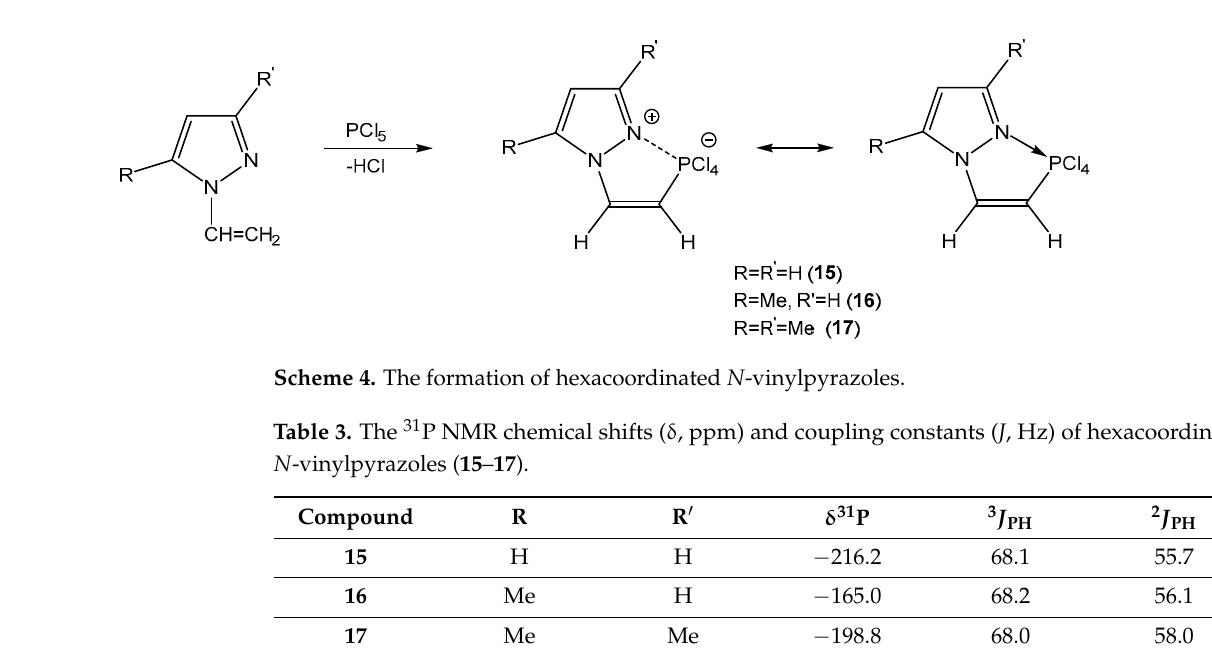
Table 3. The 31 P NMR chemical shifts ( δ , ppm) and coupling constants ( J , Hz) of hexacoordinated N -vinylpyrazoles ( 15 – 17 ).